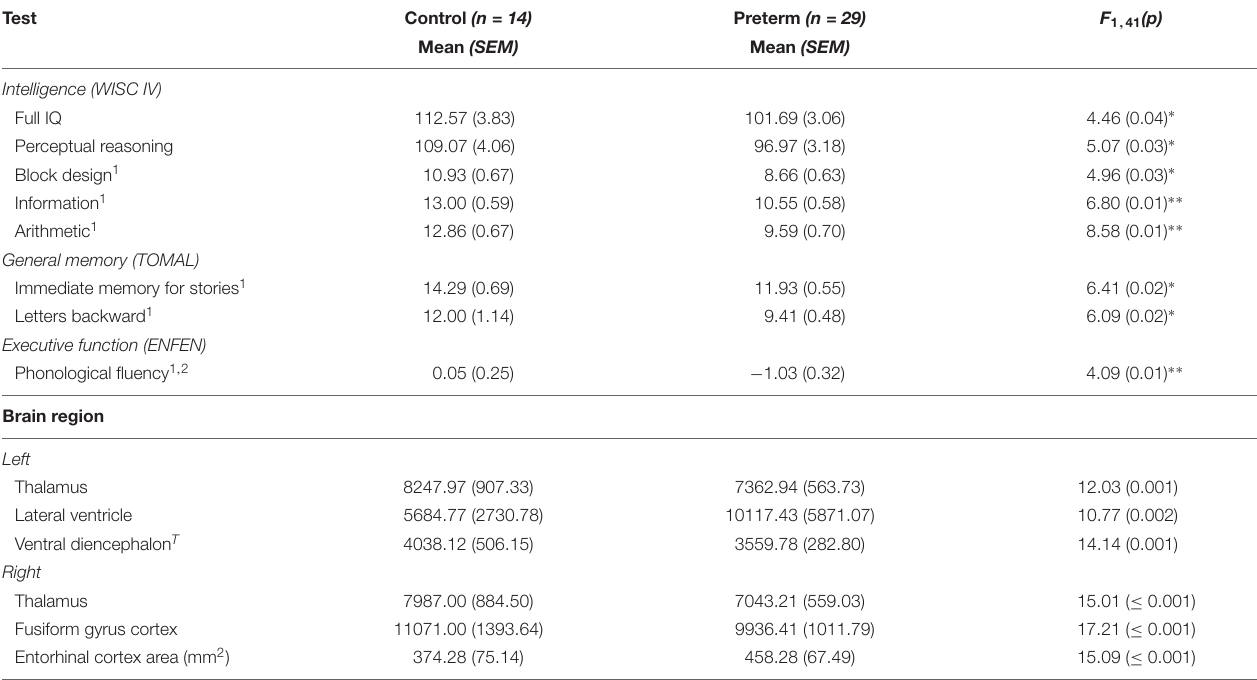
TABLE 3 | Neuropsychological and gray matter volume (mm 3 ) differences in control and preterm